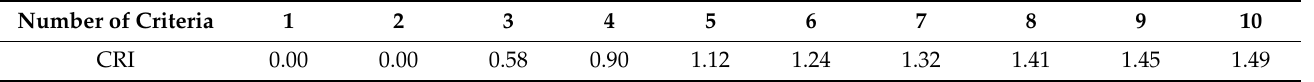
Table 2. Consistency ratio for the defined number of